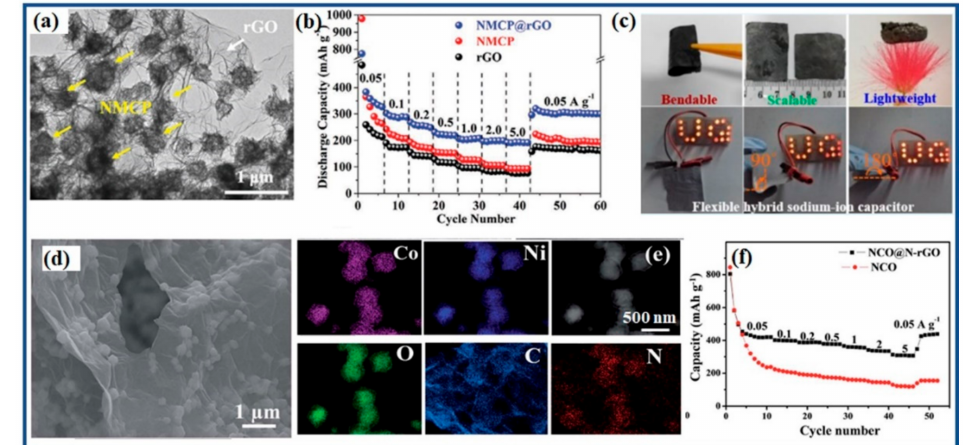
Figure 8. Graphene composites as anodes for post-Li hybrid capacitors. ( a , b ) NMCP@rGO anode for potassium-ion hybrid capacitors: ( a ) TEM image, ( b ) rate capability of NMCP@rGO potassium half- cell. Reproduced with permission [35], Copyright 2020, Wiley-VCH; ( c ) flexible sodium-ion hybrid capacitor with a graphene composite anode. Reproduced with permission [101], Copyright 2018, American Chemical Society; ( d – f ) NiCo 2 O 4 @N-doped rGO (NCO@N-rGO) as anode in a sodium-ion hybrid capacitor: ( d ) TEM image, ( e ) EDS mapping, and ( f ) rate performance of NiCo 2 O 4 (NCO) and NiCo 2 O 4 @rGO. Reproduced with permission [62], Copyright 2018, Royal Society of Chemistry. The intercalated anodes (such as TiO 2 [61], Nb 2 O 5 [60], NaTi 2 (PO 4 ) 3 [65], etc.)